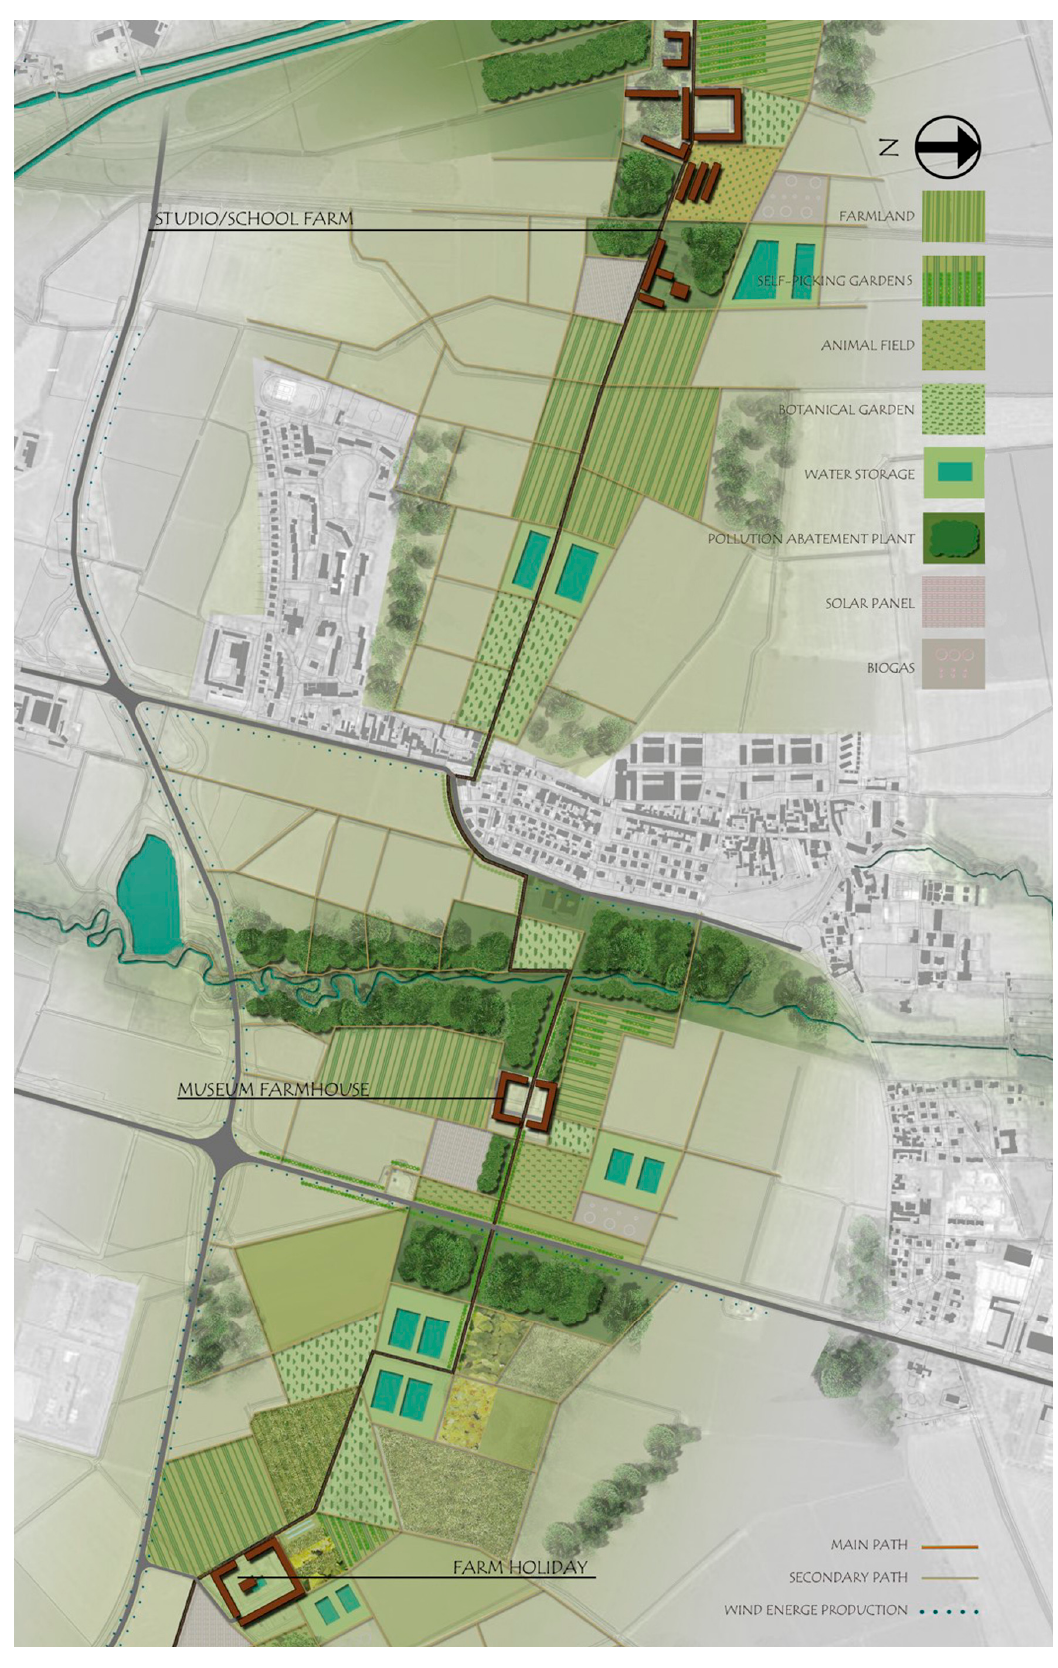
Figure 8. Master plan of the farmhouse (cascina). Notably, the new functions create new connections in the rural landscape and new visual interaction between agriculture, public spaces and historical buildings.